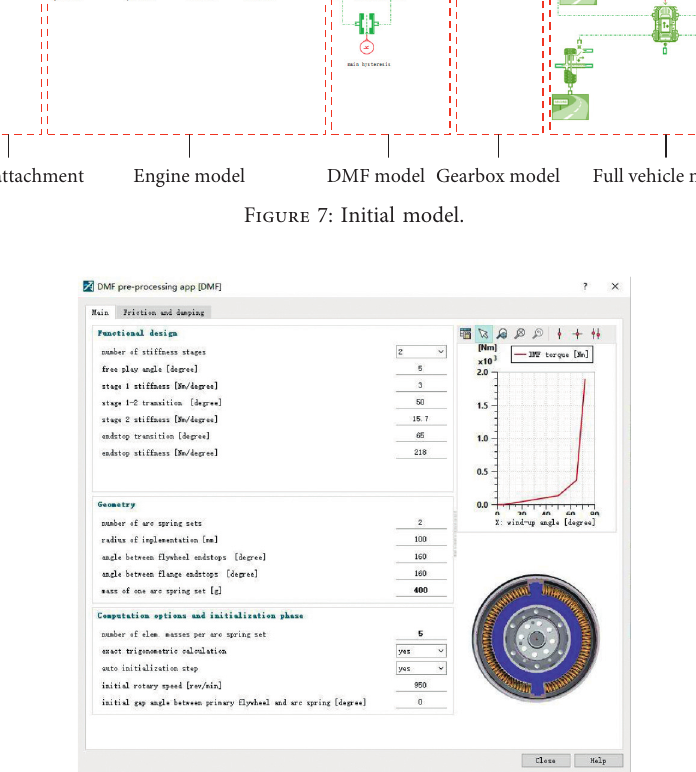
Figure 6 plots the changes in the engine torque.